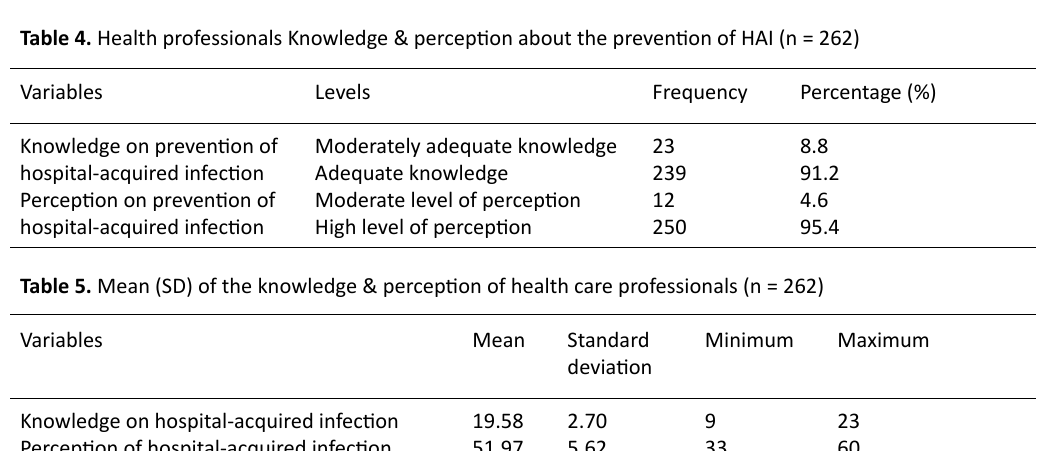
Knowledge on hospital-acquired infection